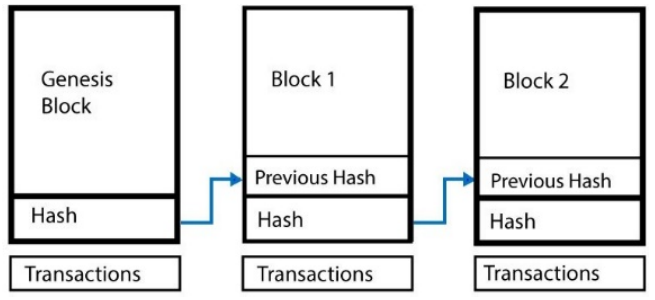
Figure 3. Blockchain architecture [62].